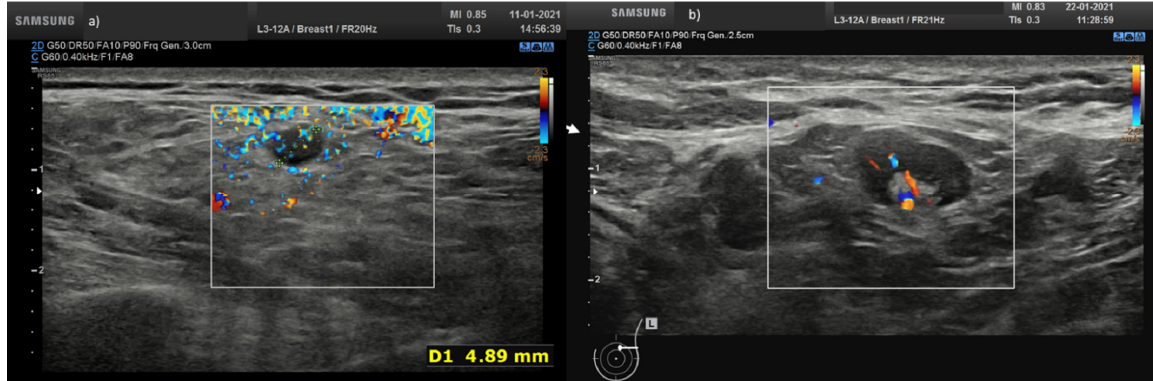
Figure 1. (a ) Hypoechoic lymph node round shape without hilum (arrow) in laterocervical side; ( b ) axillary lymph node with concentric cortical thickening with reduction in the width of the echogenic hilum and oval shape.